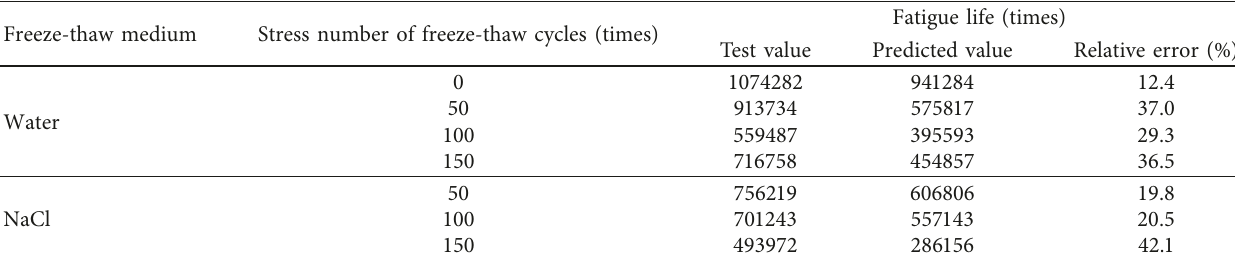
Table 9: Experimental values and predicted values of fatigue life.